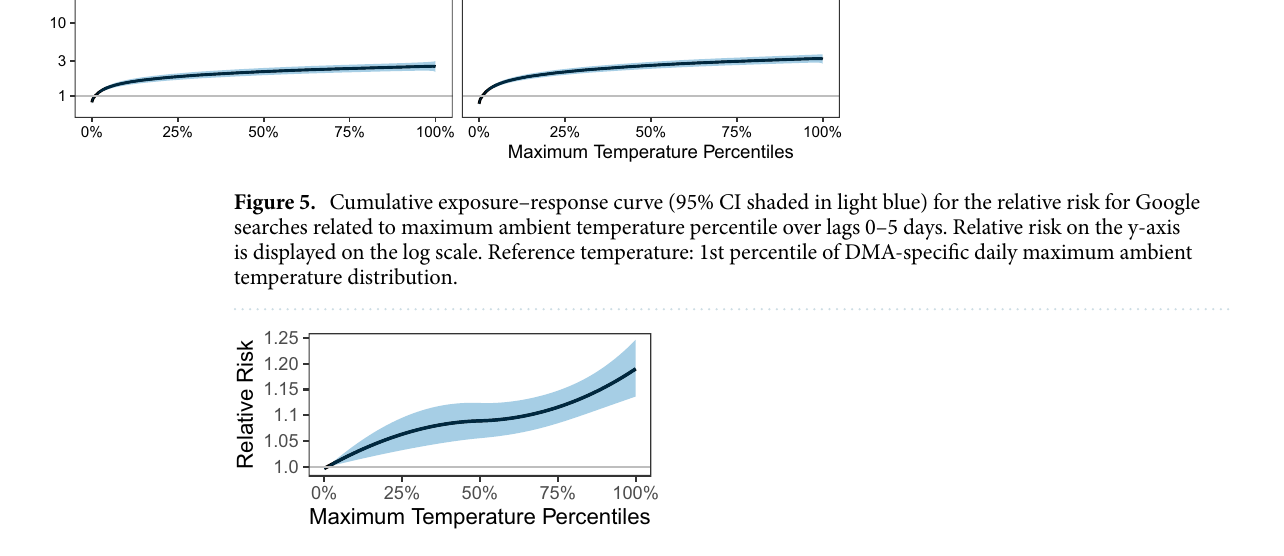
Figure 6. Cumulative exposure–response curve for the relative risk of heat-related ED visits for percentiles of DMA-specific daily maximum ambient temperature over lags 0–5 days. Reference search volume: 1st percentile of DMA-specific daily maximum ambient temperature